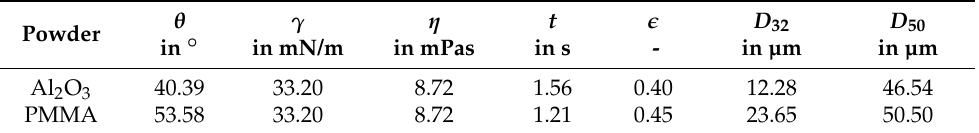
Table 1. Measured values of the variables for the calculation of the penetration depth using the Washburn equation.